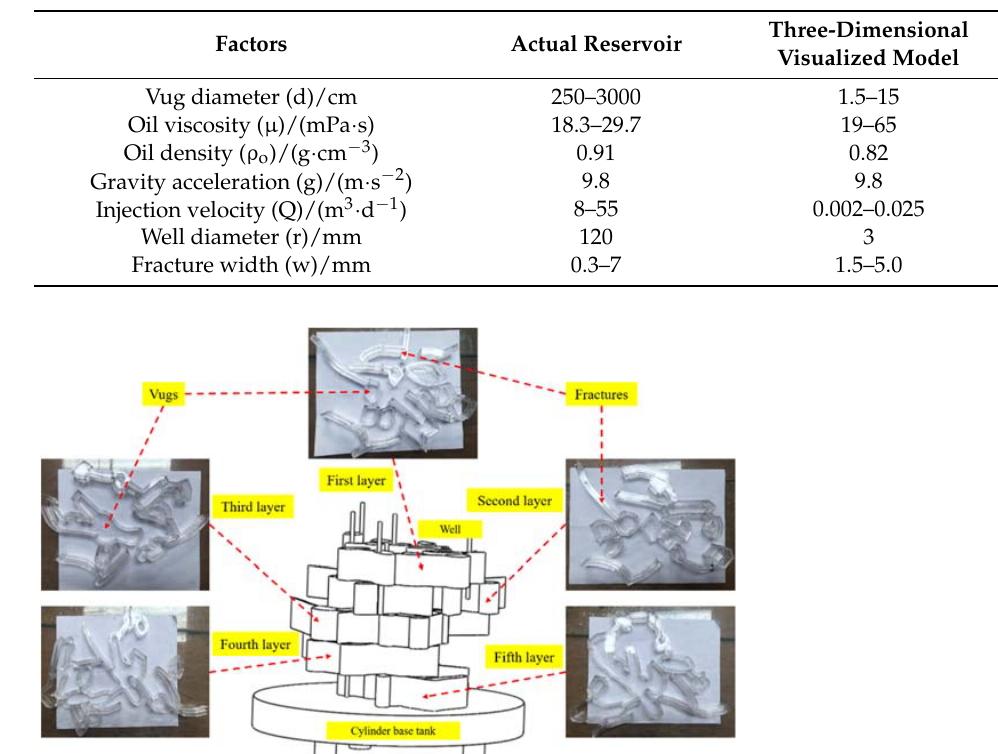
Table 3. Parameter design of the three-dimensional visualized fracture–vuggy physical model based on similarity criteria.